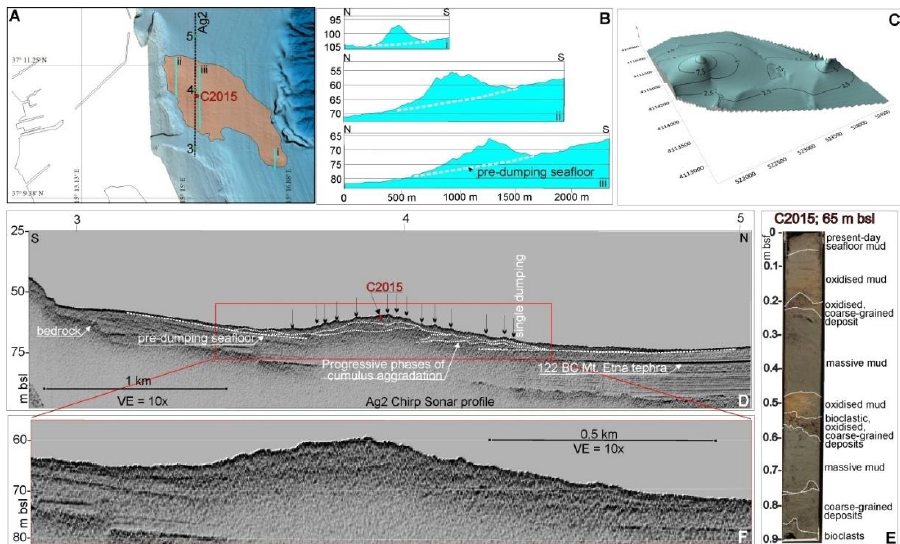
Figure 5. Example of anthropic-impacted seafloor in correspondence of a 9 m high pile of dumped dredge spoils. ( A ) Extent of the shelf area characterized by rough/mottled seafloor and marked by anthropic-induced seafloor aggradation; ( B ) topography of the seabed across the main depocenters of dumped materials (location of profiles is in ( A )); ( C ) isopach (m) of two cumuli above the pre- dumping seafloor; ( D ) Chirp Sonar profile (Ag2) across the highest cumulus and site of the gravity core described in ( E ) the gravity core was sampled at the topmost site of the cumulus; ( F ) enlarged and un-interpreted detail of dredge spoil cumulus.